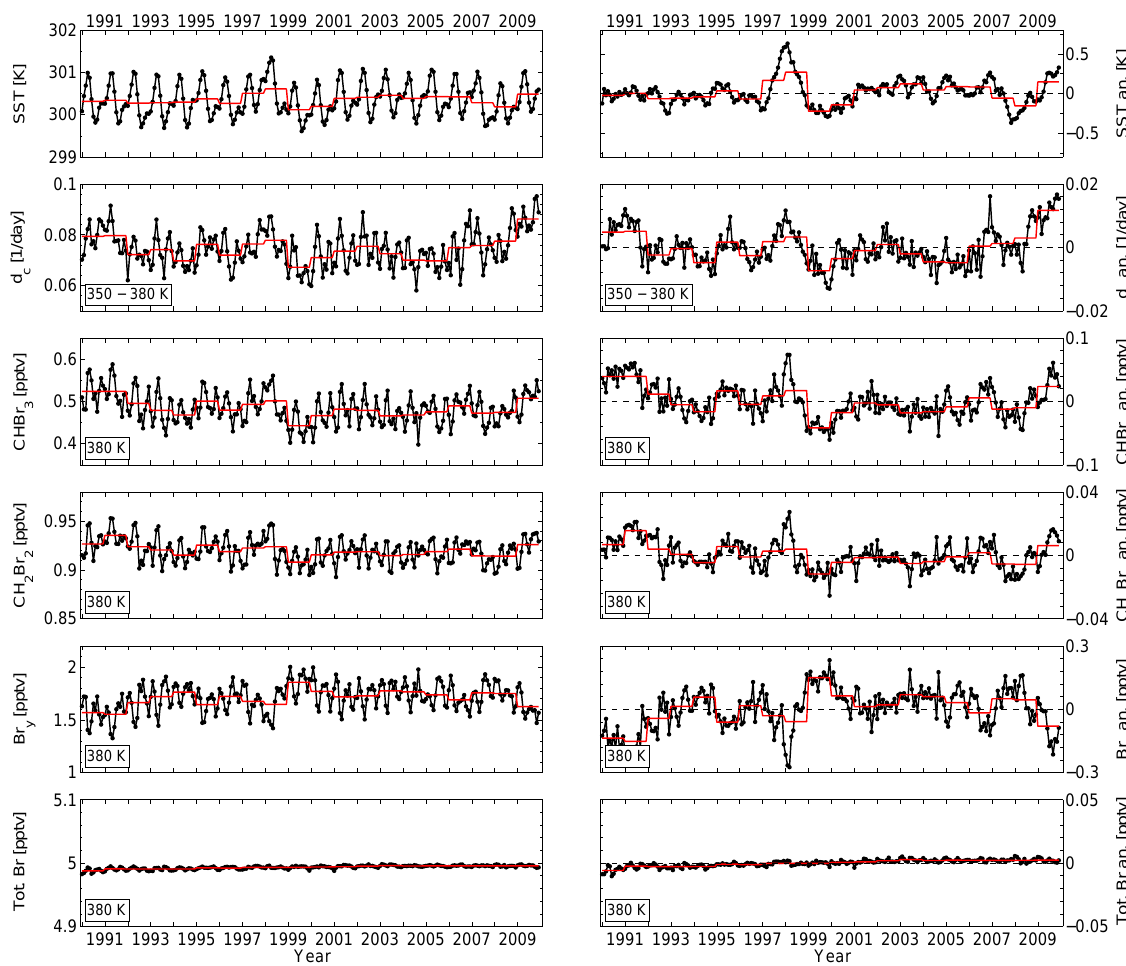
Fig. 10. Timeseries of monthly mean sea surface temperature SST, detrainment rate d c , bromoform (CHBr 3 ), dibromomethane (CH 2 Br 2 ), inorganic brominated product gases (Br y , see Table 1) and total bromine (left panels) and the corresponding anomalies (right panels) from 1990 to 2009 averaged over the tropics (20 ◦ N to 20 ◦ S) at an altitude of approximately 17km (380K) for the tracers. The values for d c are an average of the range between the level of zero radiative heating and the cold point (350–380K). The red lines denote the corresponding yearly average. Note: the values for Br y and total bromine are actually the difference of the standard full chemistry run and the reference run without VSLS to show the impact of the short-lived substances.